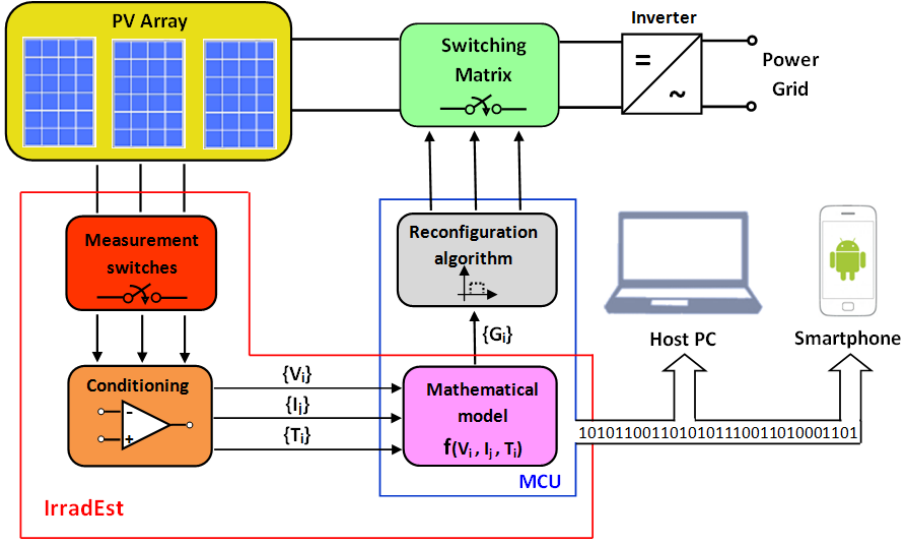
Figure 6. A reconfigurable PV system taking advantages of the irradiance estimations performed by the